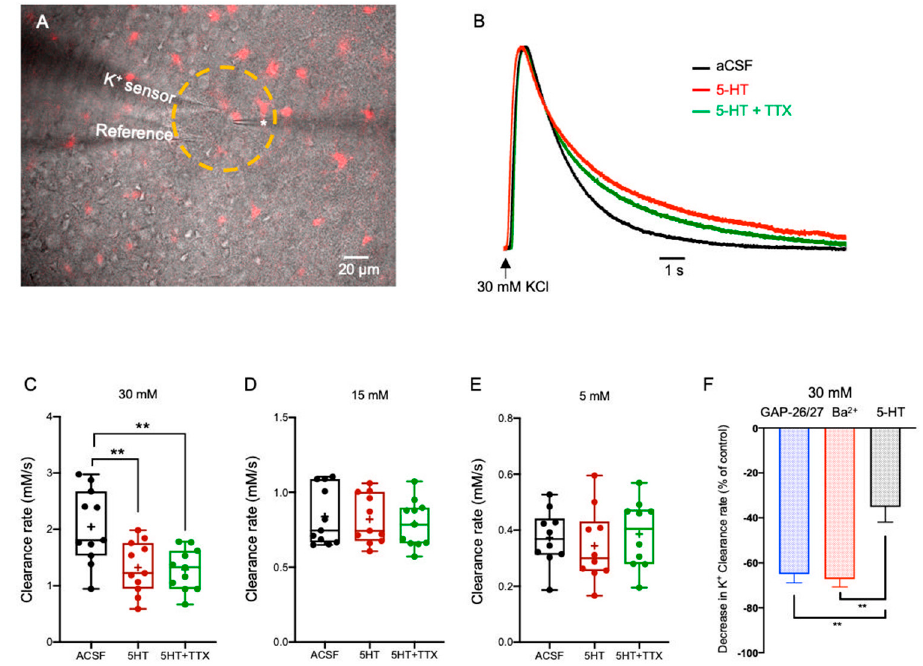
Figure 3. The impact of 5-HT on the K + clearance rate. ( A ) Merged image of DIC (grey) and SR-101 (red) staining depicting the experimental setup, including the K + recording electrode, the KCl puffing electrode (*) and the photo-activated region (yellow circle, 360 nm for 1 s prior to local application of KCl) used for the application of the neuromodulators 5-HT (NPEC-caged-Serotonin, 30 µ M) and Dopamine (NPEC-caged-Dopamine, 10 µ M). ( B ) Sample traces of [K + ] o recordings depicting the K + clearance time course following local application of 30 mM KCl (arrow), before (aCSF, black) and after focal photolysis of 30 µ M caged Serotonin (5-HT, red) or 30 µ M caged 5-HT with 1 µ M TTX (green). ( C – E ) Box plots depicting the K + clearance rate following local application of 30 mM ( C ), 15 mM ( D ), and 5 mM ( E ) KCl before (black dots) and after photolysis of 5-HT (red dots) or 5-HT + TTX (green dots). ( F ) Bar graph depicting the average decrease in K + clearance rate (as % from control) following blockade of Kir4.1 channels by Ba 2+ (red); blockade of Cx43 channels by a mix of GAP26/27 mimetic peptides (blue), or photolysis of 5-HT (black) together with a local application of 30 mM KCl. Box plot definitions is the same as in Figure 1. ** p < 0.01; two-way ANOVA.